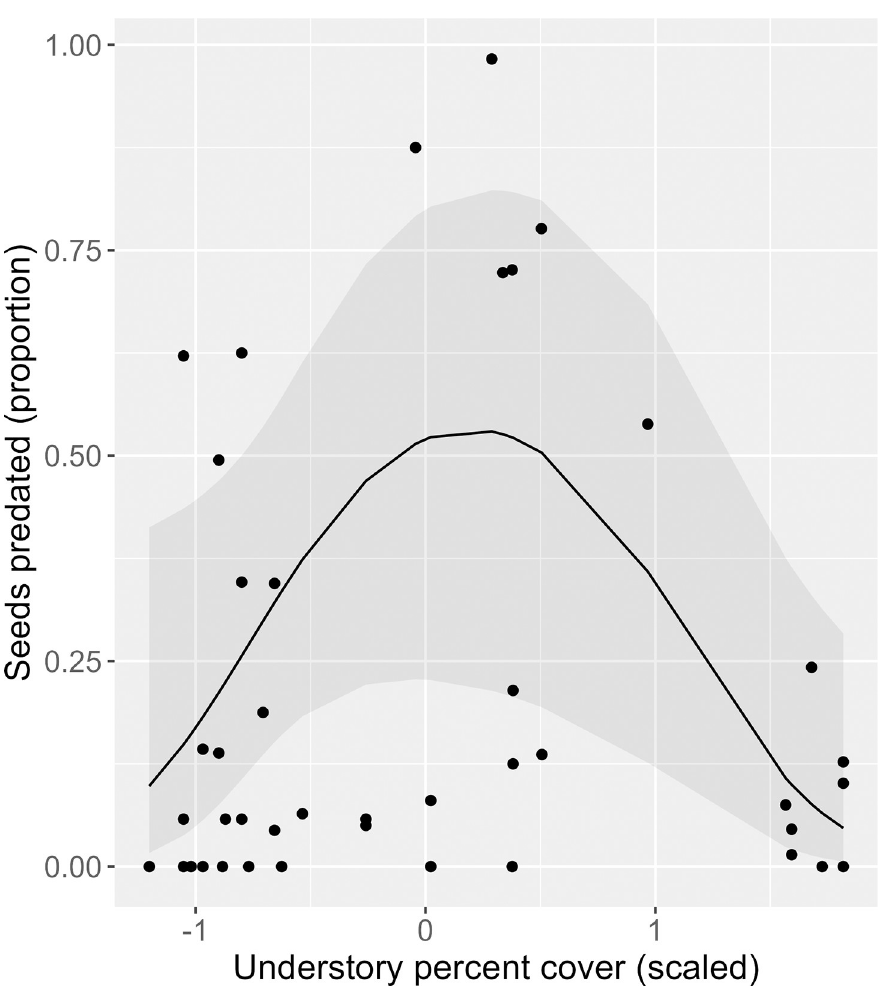
Fig 1. Relationship between pre-dispersal predation of Lindera subcoriacea seeds (proportion) and understory cover (scaled and centered). Points are individual observations, the line is from a mixed-effects generalized linear regression model with a quadratic effect (full model), and shaded region is the 95% confidence interval. were observed at the 5 and 10 m scales for the number of seeds dispersed and at all three scales for the proportion of seeds dispersed (Table 3; Fig 4). No other intrinsic or extrinsic drivers had a significant effect on the number or proportion of seeds dispersed (Table 3). Frugivores documented with camera traps at fruiting L . subcoriacea included the American Robin ( Turdus migratorius L.), Grey Catbird ( Dumetella carolinensis L.), Red-headed Wood- pecker ( Melanerpes erythrocephalus L.), and White-eyed Vireo ( Vireo griseus Boddaert). Given that these four species all have bill gape widths larger than the fruits/seeds of L . subcoriacea , they are interpreted to be dispersers. The mean occupancies estimated for the American Robin, Red- headed Woodpecker, and White-eyed Vireo within L . subcoriacea populations across Fort Bragg were 0.35 ± 0.14, 0.23 ± 0.10, and 0.13 ± 0.05, respectively. Bootstrapped confidence inter- vals for the differences in occupancy estimates among species pairs indicated that frugivore occupancies differed, and were lower than Northern Cardinal occupancy (S3 Table). We could not include Grey Catbird in this comparison because insufficient observations ( < 10) during avian surveys prevented us from generating an occupancy map for this species.